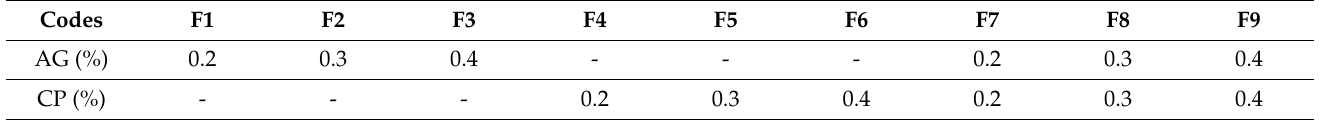
Figure 9. Schematic procedure for the preparation of SGs loaded with drugs. Table 6. Composition of mucoadhesive smart gel formulations (%, w / v ).